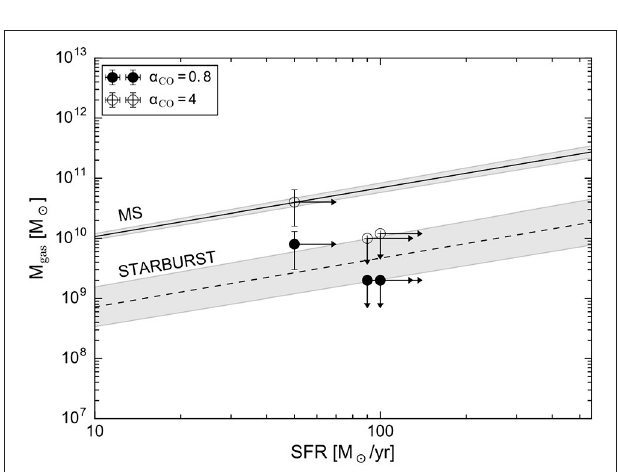
FIGURE 4 | M gas -SFR plane from Carniani et al. (2017). The solid black line is the best-fit relation for main sequence galaxies and the dashed indicate the relation for the starburst galaxies (Sargent et al., 2014). Filled black circles corresponds to the three QSOs assuming a α CO = 0.8 M ⊙ /K km/s pc 2 and open circles are derived supposing a α CO = 4 M ⊙ /K km/s pc 2 . Credit: Carniani, A&A, 605, A105, 2017, reproduced with permission ©